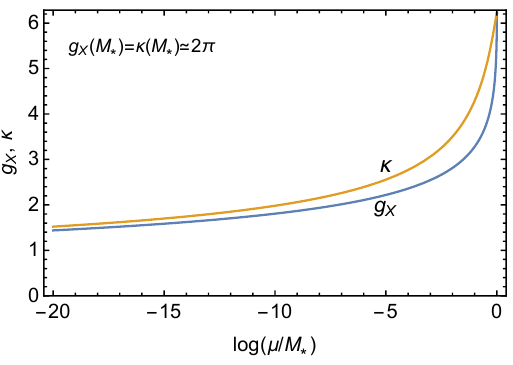
Figure 1 . Running of g X and (cid:20) from a high energy scale M (cid:3) down to lower energy scales. from a high energy scale M towards low energy scales, with a boundary condition at M (cid:3) of g = (cid:20) ’ 2 (cid:25) . M can be identi(cid:12)ed with the Landau pole scale. The running of g (cid:3) X